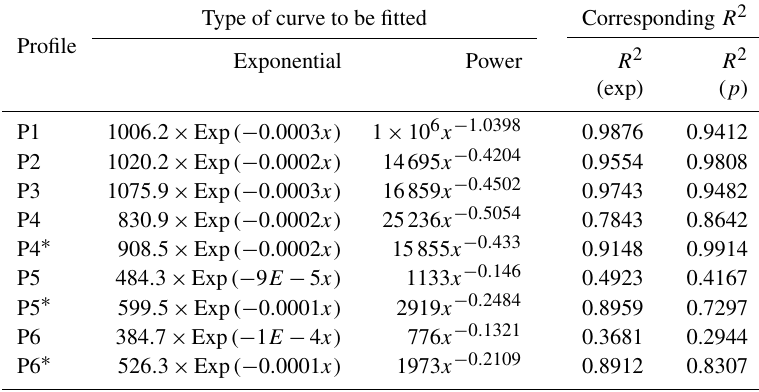
Table 1. Correlations of several profiles from the DTM data and curve-fit results.